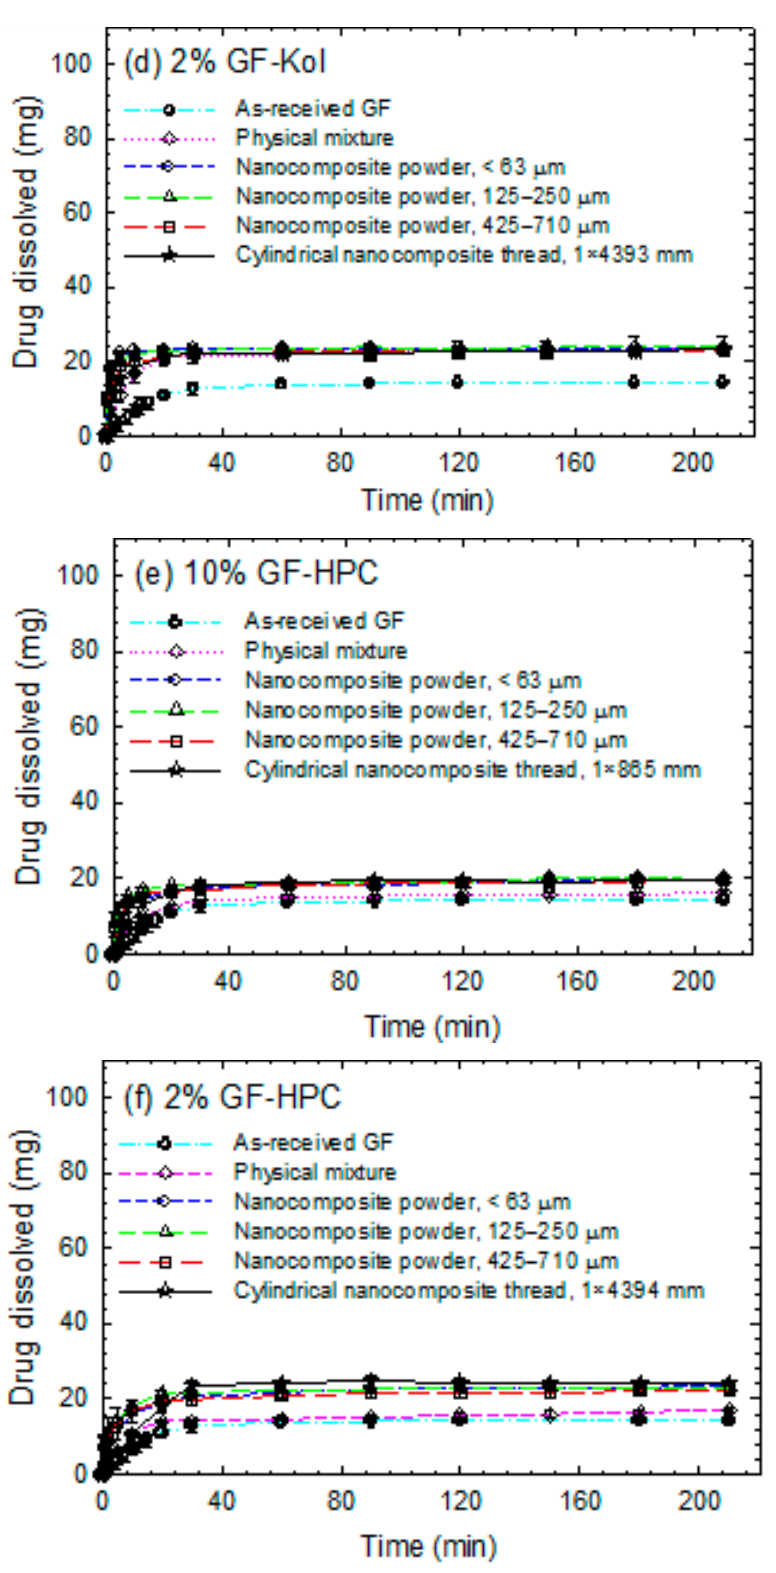
Figure 7. Evolution of GF release during dissolution of as-received GF microparticles, physical mixtures (PMs), thread of the extrudate, and extrudate powders with various formulations–sieve fractions: ( a ) 10% GF-Sol, ( b ) 2% GF-Sol, ( c ) 10% GF-Kol, ( d ) 2% GF-Kol, ( e ) 10% GF-HPC, and ( f ) 2% GF-HPC. The sample size is equivalent to 100 mg GF dose (supersaturating condition).